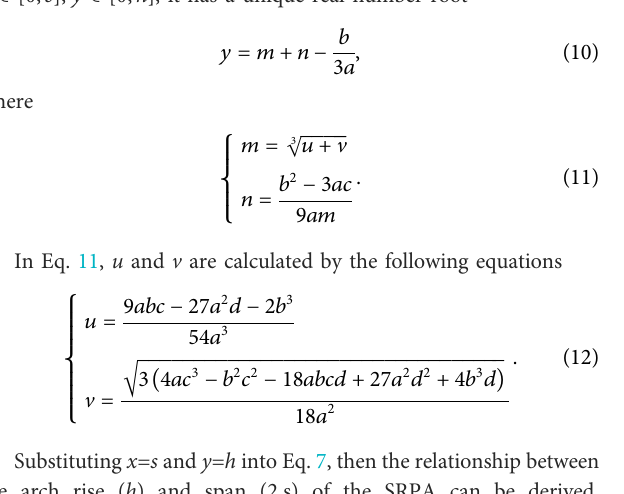
where δ 11 and δ 22 are the displacements generated under the action of displacements of point C along the X 1 and X 2 directions under the action of external force. According to the displacement calculation equation of the statically determinate structure, the rotation angle and displacement δ 11 and δ 22 of point C under the action of unit force